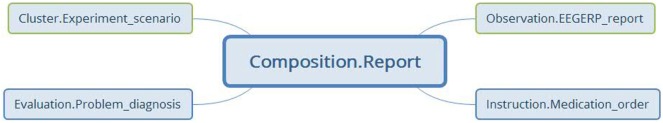
The newly proposed (green) and existing (blue) archetypes connected into Composition RM.